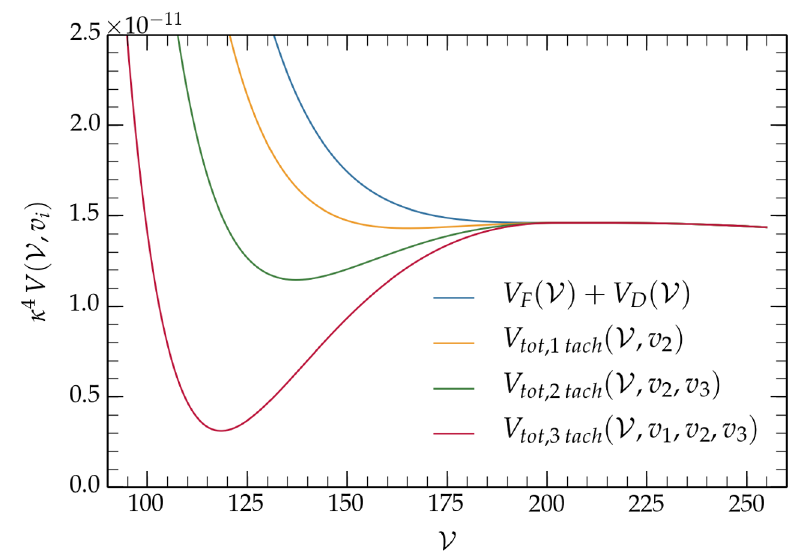
Figure 2 . Value of the global minimum of the effective scalar potential as a function of V , without ( blue ), with one ( orange ), two ( green ) or three ( red ) tachyons. The parameters are such that V c 2 = V − , V c 3 = 0 . 99 V − and V c 1 = 0 . 98 V −